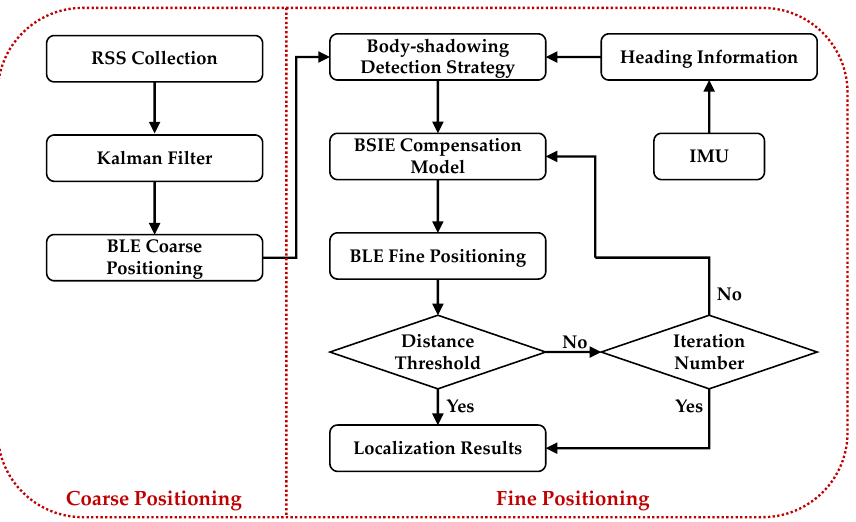
Figure 7. The flow chart of the body-shadowing error compensation (BP-BEC) algorithm.